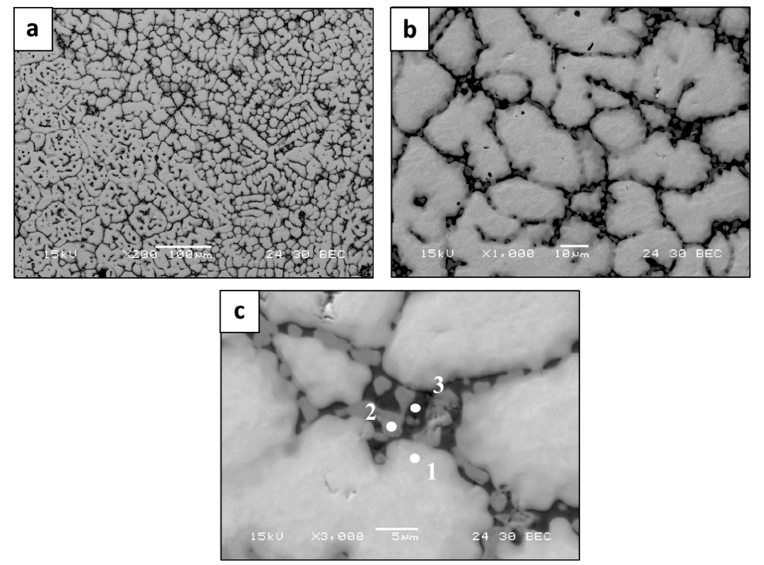
Figure 5. Microstructure by SEM backscattered electron mode of HEA WTaMoNbV produced by AMF process: ( a ) general appearance, ( b ) close-up view, and ( c ) magnified view of grain boundaries. Table 7. Local chemical compositions (at. %) by EDS analysis; related to Figure 5c.